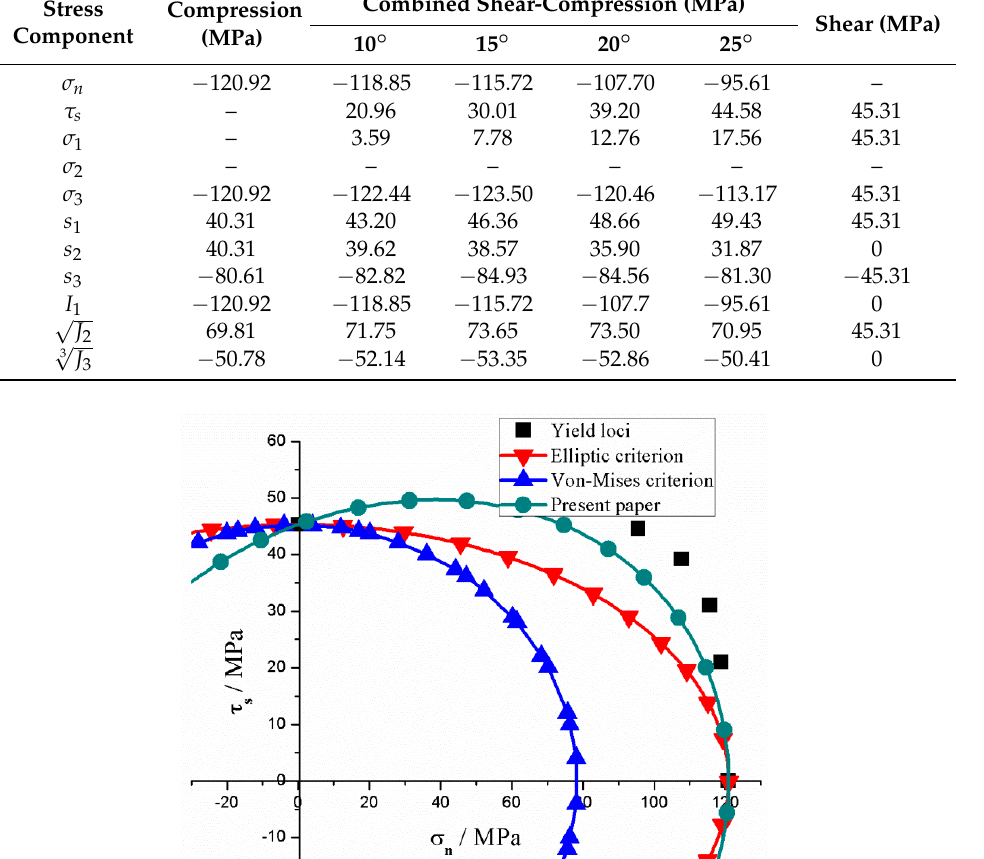
Figure 2. Comparison of experimental yield loci and theoretical models of PMMA in shear–normal stress space.